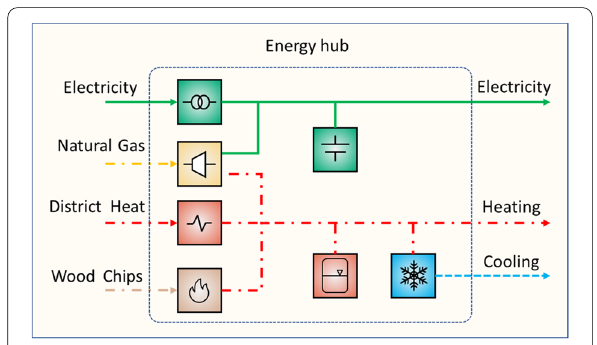
Fig. 9 Energy hub example sketch